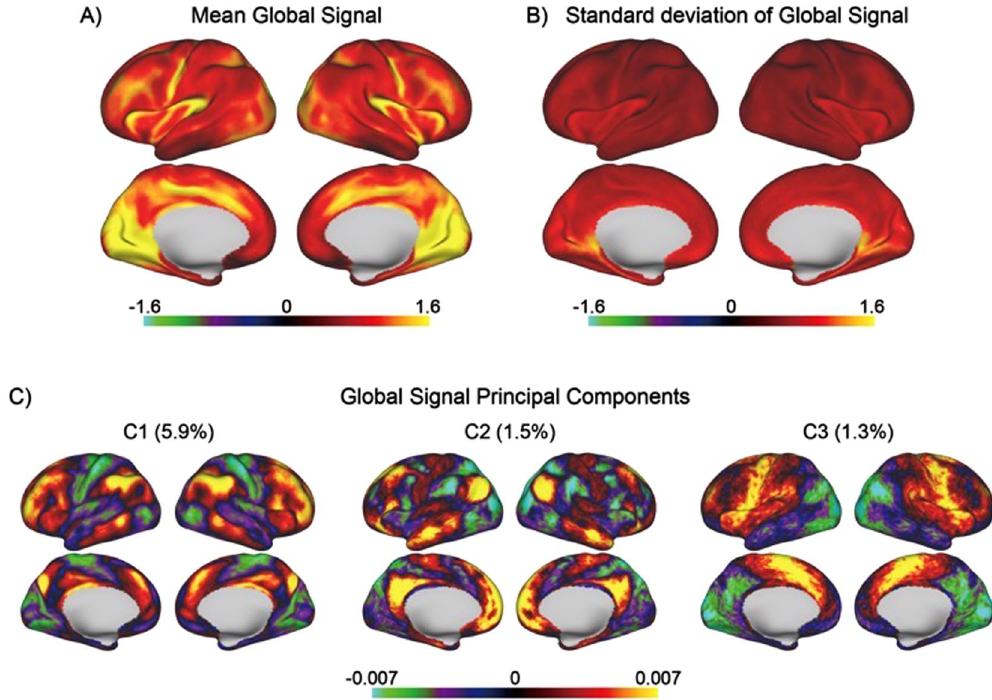
Figure 2. Global signal topography. ( A) Brain regions dominating the global signal, computed as the mean global signal beta map across all subjects per vertex. Brain regions with strong global signal include the visual cortex, posterior insula, central sulcus and cingulate sulcus. ( B) Brain regions with high individual variation (standard deviation) of global signal topography include retrosplenial and visual cortex. ( C) Global signal principal components computed across subjects. The patterns resemble the canonical brain networks regularly observed from decompositions of resting-state fMRI